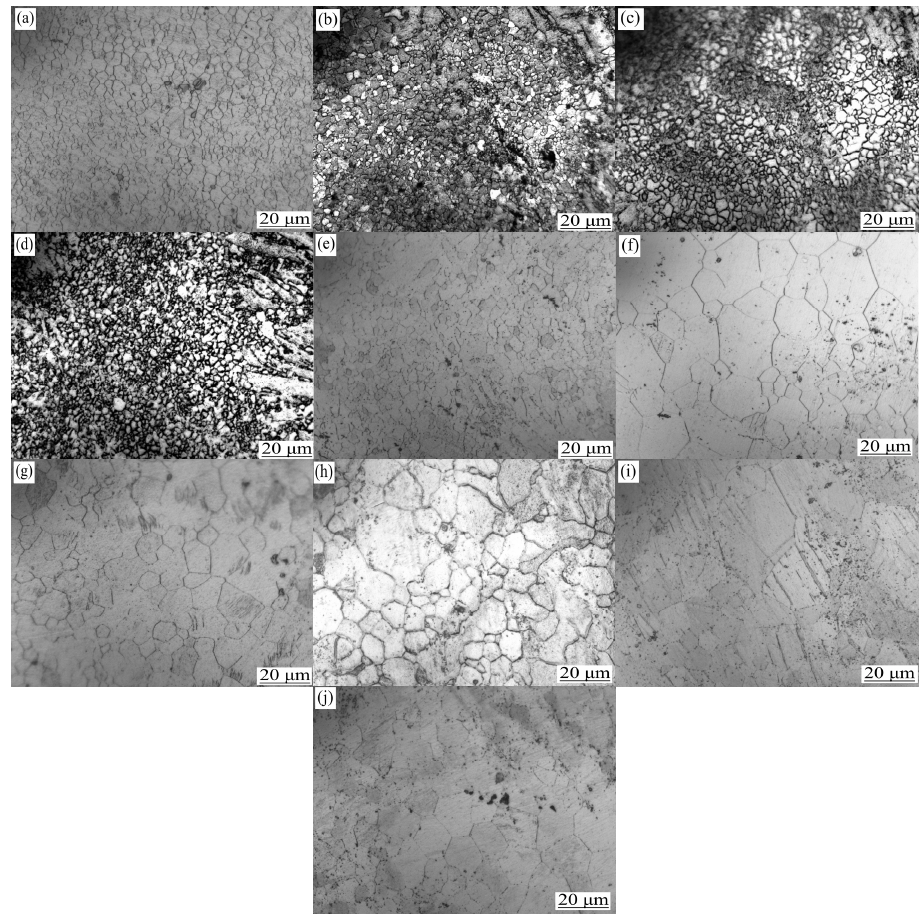
Figure 1. Microstructure of ZK60 magnesium in heat treat state. ( a ) Hot rolled state; ( b ) at 170 °C for 4 h; ( c ) at 170 °C for 12 h; ( d ) at 170 °C for 24 h; ( e ) at 190 °C for 12 h; ( f ) at 400 °C for 3 h; ( g ) at 400 °C for 3 h and 170 °C for 4 h; ( h ) at 400 °C for 3 h and 170 °C for 12 h; ( i ) at 400 °C for 3 h and 170 °C for 24 h; ( j ) at 400 °C for 3 h and 190 °C for 12 h.